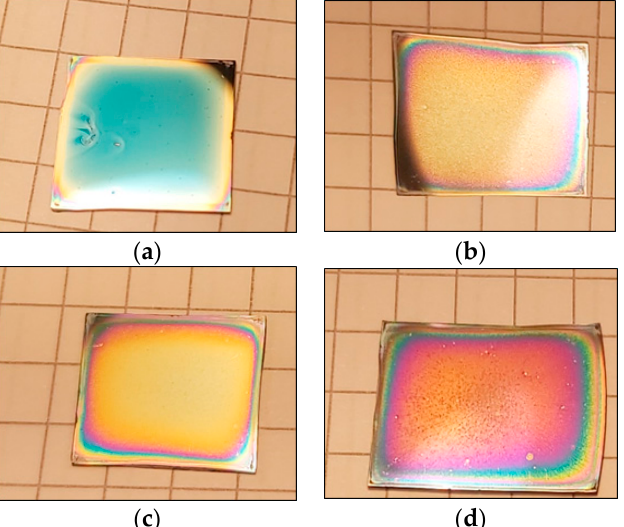
Figure 4. Surface appearance of ZnO/Ag(NPs) nanocomposite thin films deposited on a c-Si substrate, with a size of about 20 × 20 mm 2 and prepared with different Ag NPs contents: 0% ( a ), 5% ( b ), 10% ( c ), and 30% ( d ).